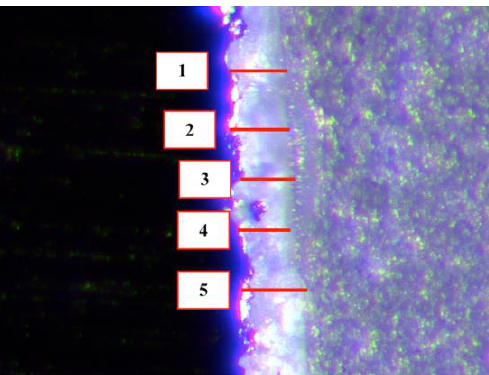
Figure 4. Five equidistant linear measurements using a Stereoscopic Microscope at 40× magnification. The recorded results were evaluated and compared statistically considering luting agent and total occlusal convergence angle as